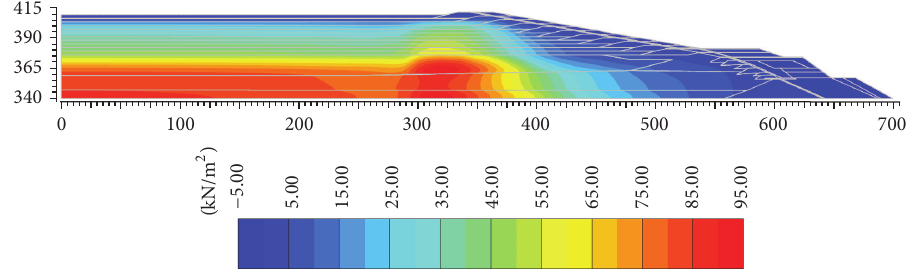
Figure 11: Excess pore pressures in the dam after 11th raising. Negative sign indicates suction.